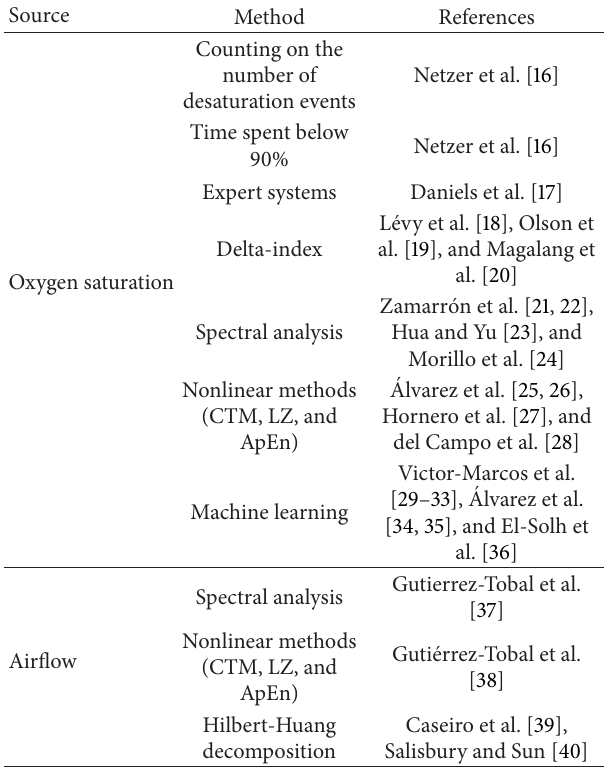
Table 1: Summary of SAHS screening